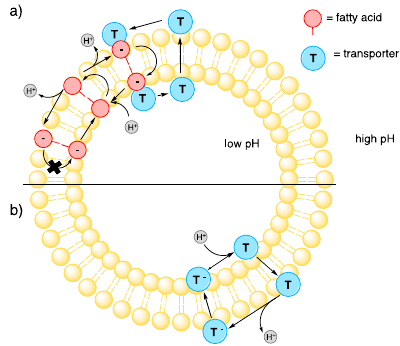
Figure 1. ( a ) Transporter-facilitated fatty acid flip-flop pathway and ( b ) the receptor acting as a weak-acid protonophore, which can both result in the dissipation of a pH gradient across a lipid bilayer.